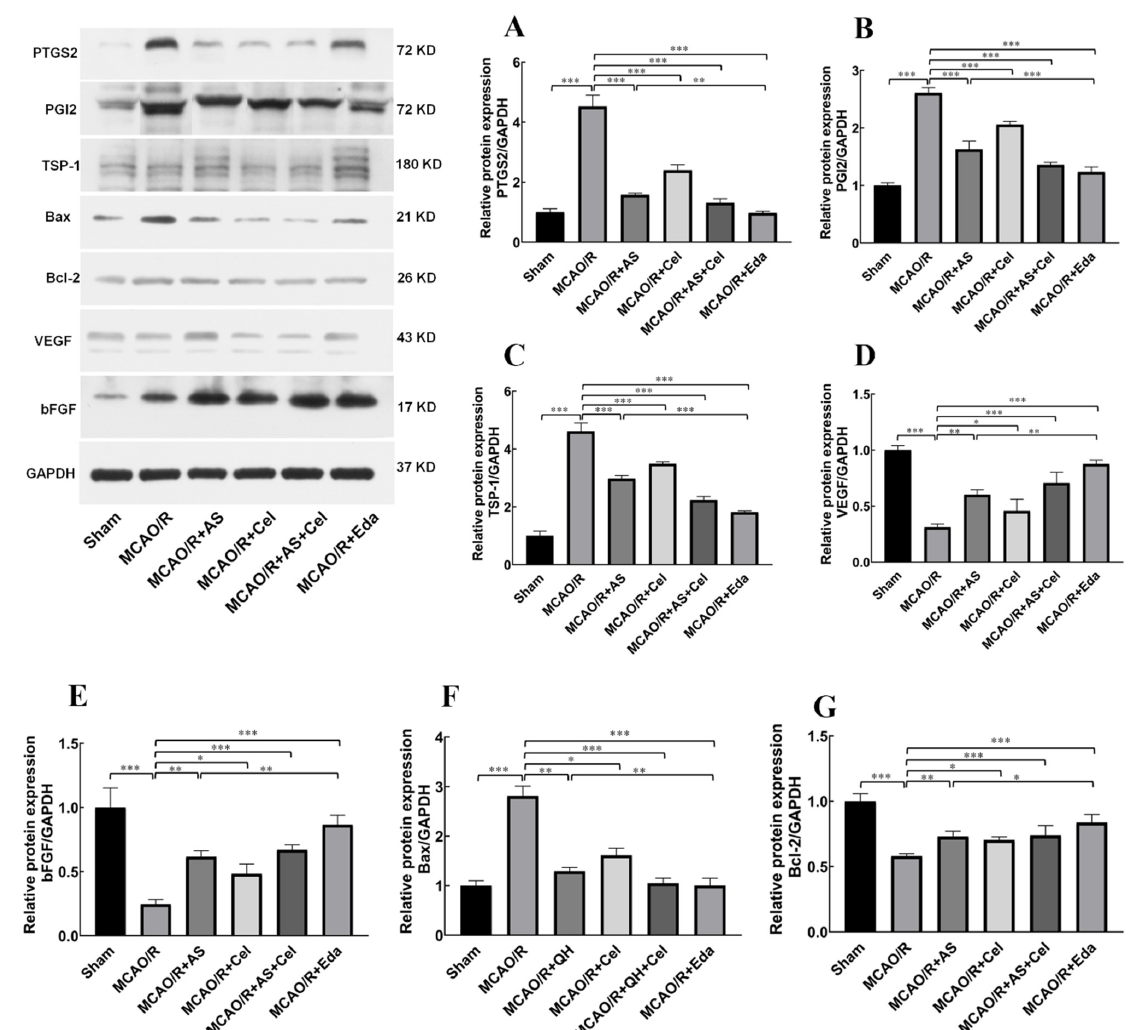
Figure 7. AS treatment promoted angiogenesis by inhibiting PTGS2. The protein expression of PTGS2 ( A ), PGI2 ( B ), TSP-1 ( C ), Bax ( D ), Bcl-2 ( E ), VEGF ( F ), and bFGF ( G ) was detected by Western blot. (n = 3 rats for each group). Data are expressed as the mean ± SD, * p < 0.05; ** p < 0.01; *** p < 0.001; ns stands for no statistical significance.